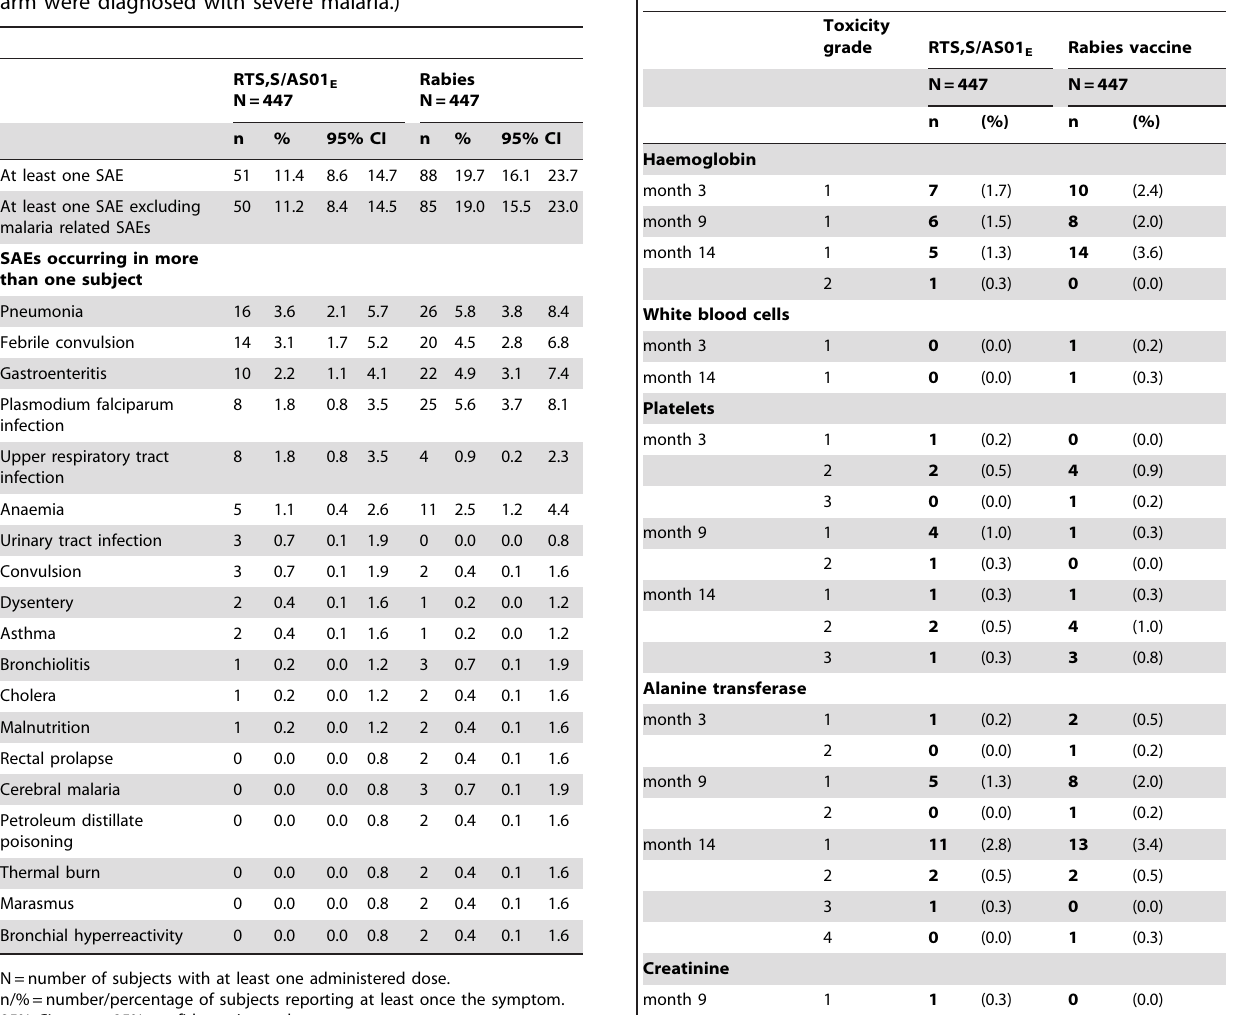
Table 6. Frequency (%) of abnormal laboratory results following